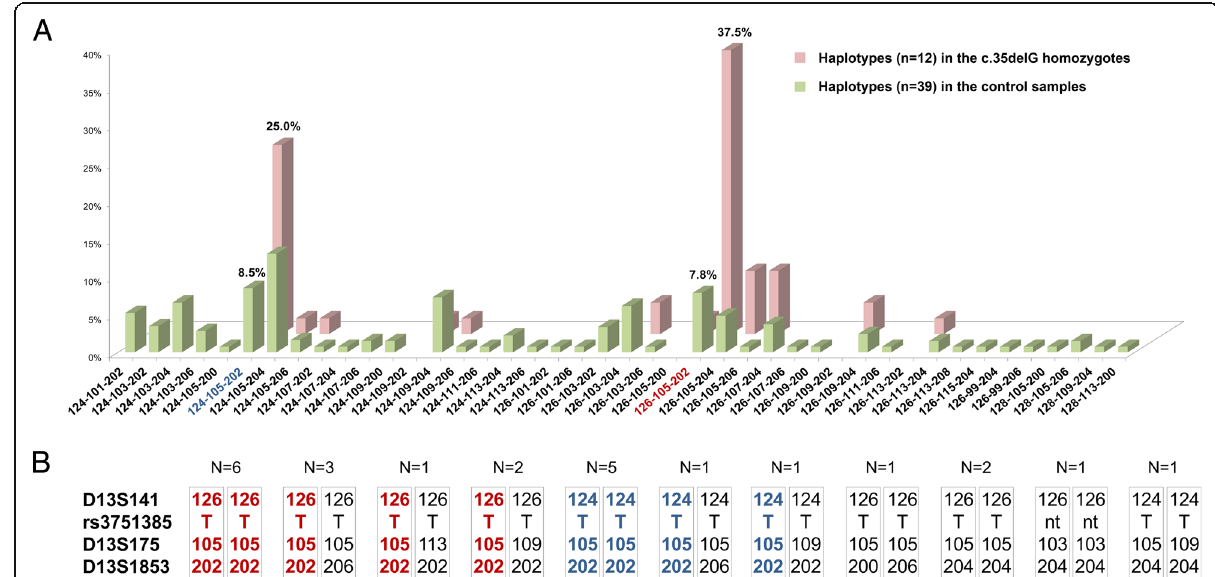
Fig. 2 The D13S141-D13S175-D13S1853 haplotypes in studied samples. a Distribution of the D13S141-D13S175-D13S1853 haplotypes reconstructed by the Arlequin software (EM algorithm) in the c.35delG homozygotes (pink bars) and in the control samples (green bars) (see explanation in text). n – number of haplotypes. b The D13S141-rs3751385-c.35delG-D13S175-D13S1853 haplotypes found in the c.35delG homozygotes. N - number of individuals. The most frequent haplotypes are highlighted in color: 126-T-105-202 – by red, 124-T-105-202 – by blue; nt - not tested